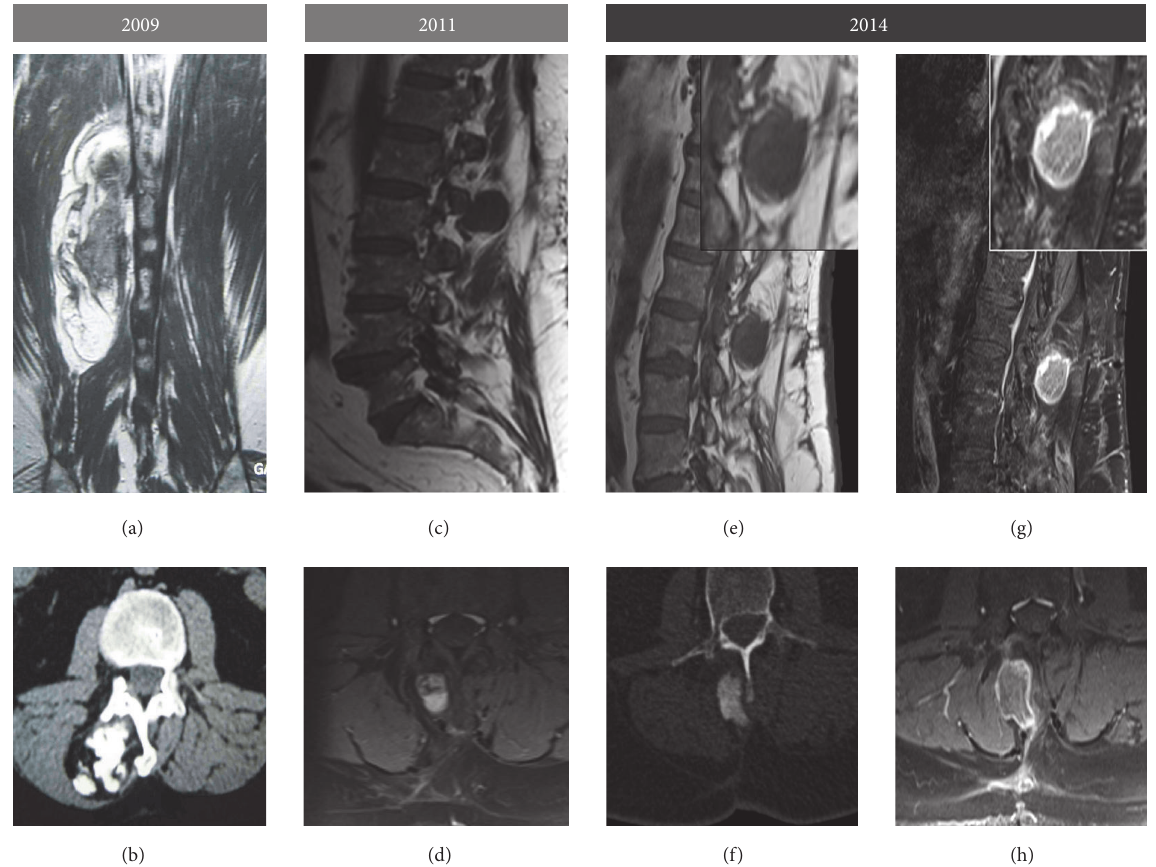
Figure 1: Imaging data of the different occurrences of the tumor: Gadolinium enhanced T1-weighted MR sequence, coronal section (a), Gadolinium enhanced T1-FATSAT weighted MR sequence, parasagittal (g), and axial sections (h), CT scan without injection, axial sections (b), T1-weighted MR sequence, parasagittal sections (c and e), and T1-FATSAT weighted MR sequence, axial section (d and f). There was no obvious radiological connection of the mass with the underlying bone, ruling out a surface tumor. Histological areas corresponding to bone formation were seen as calcified clusters on CT scans, surrounded by a peripheral rim of tumorous fat identified as hypersignal in T1-weighted RM sequences. The two local recurrences showed similar features; however, the ossified core was more homogeneously calcified compared to the first